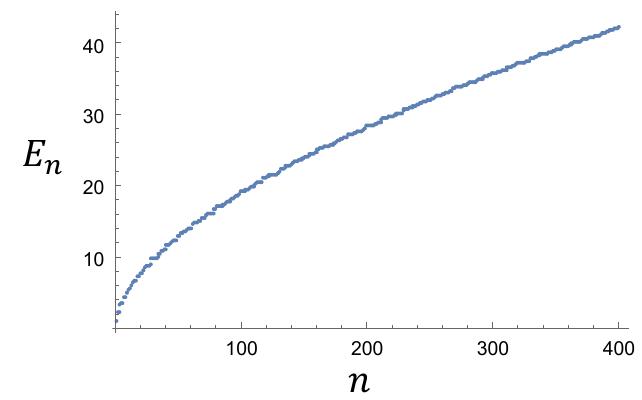
Figure 3 . Energy eigenvalues of the CHO Hamiltonian with ! = 1 and g 0 = 1 =